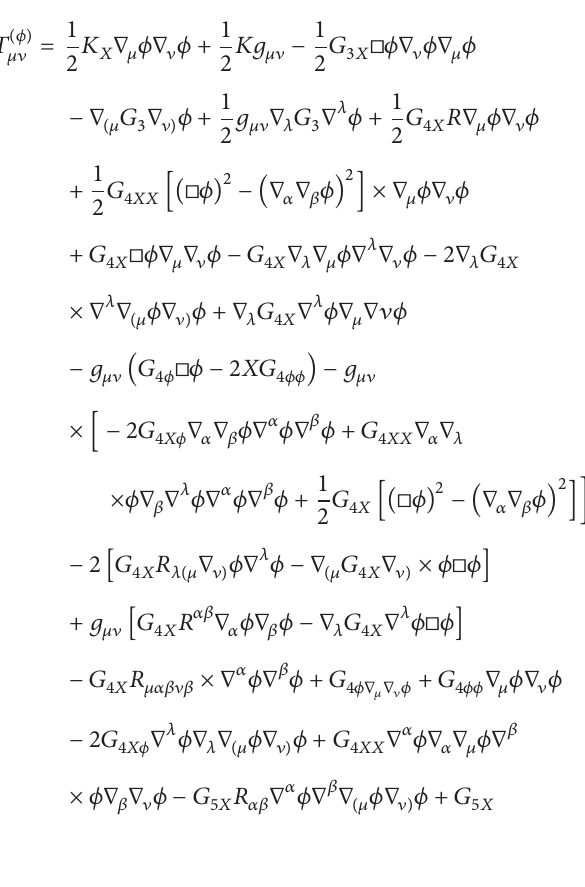
Galilean model. In each case, there are many free